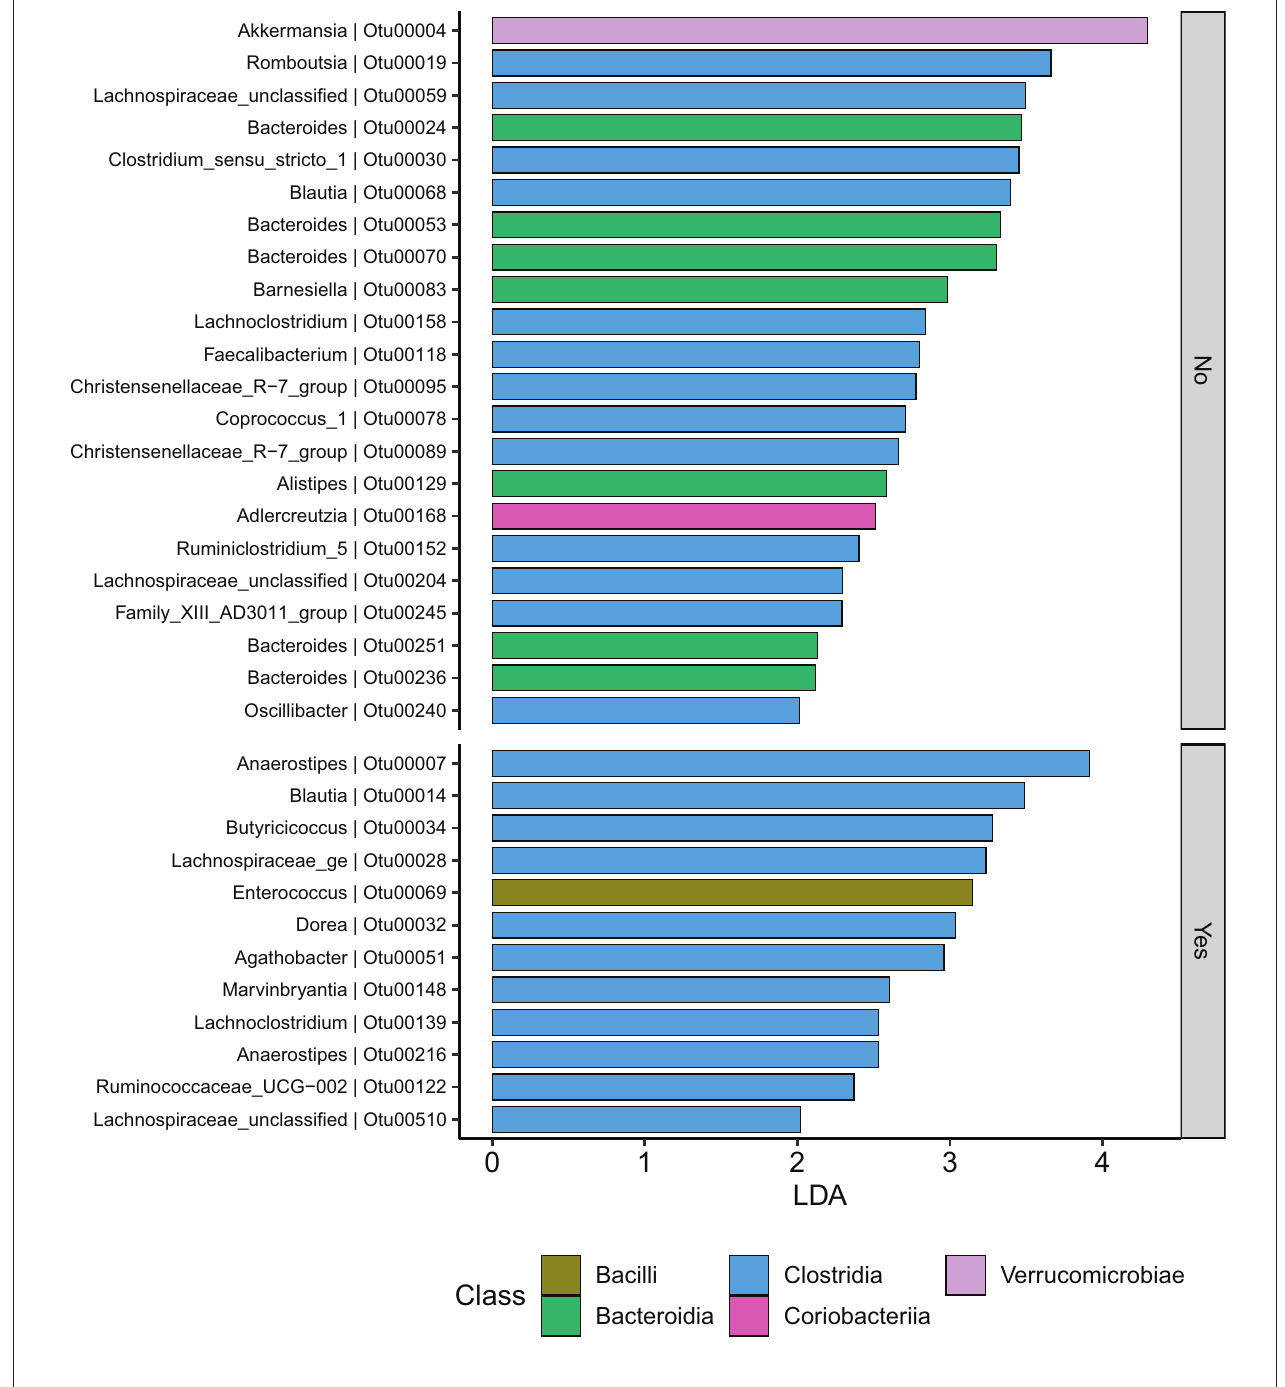
FIGURE 8 | CD participants-Microbial biomarkers. OTUs microbial biomarkers for CD groups with two treatment options including biologic treatment (Yes) and non-biologic treatments (No) (OTUs and Genus information on Supplementary Table 14 ).